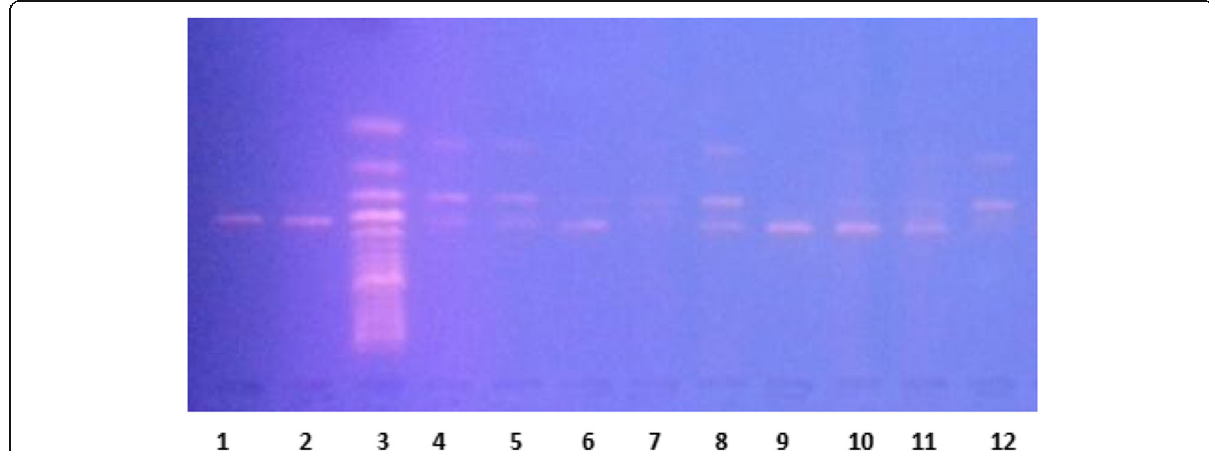
Fig. 1 Gel electrophoresis images. Lanes 1 and 2: PCR product (206). Lane 3: DNA marker. Lanes 4, 5, and 8: three bands (206 bp, 130 bp, and 76 bp C/T genotype). Lanes 6, 9, 10, and 11: one band (206 bp to T/T genotype). Lane 12: two bands (130,76 bp fragments to the C/C genotype)